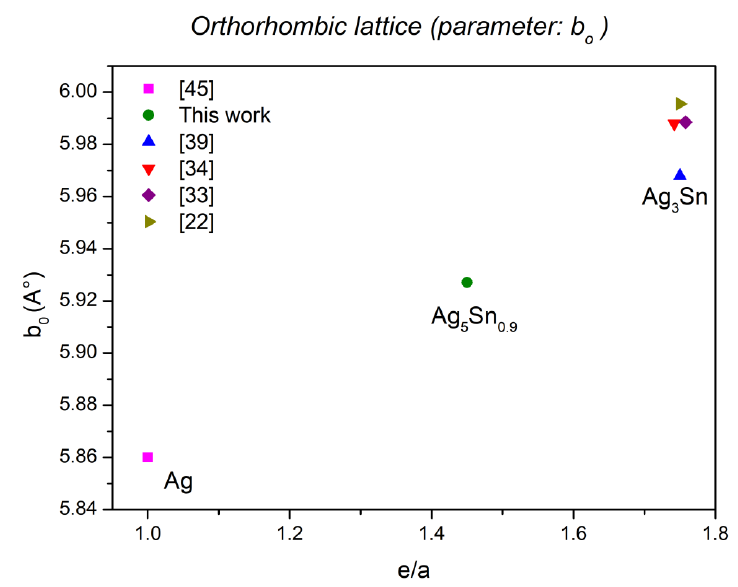
Figure 9. Evolution of the parameter b o as function of Fig 9